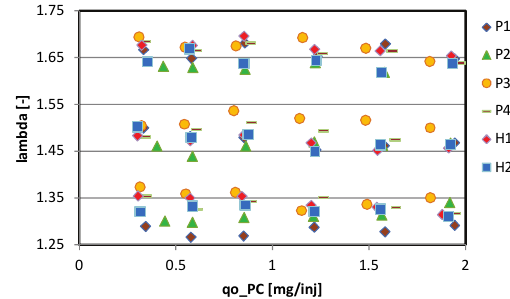
Fig. 5. Values of excess air coefficient and fuel dose before normalization Based on the raw data three lambda values (1.65; 1.5; 1.32) were selected as representative for three loads